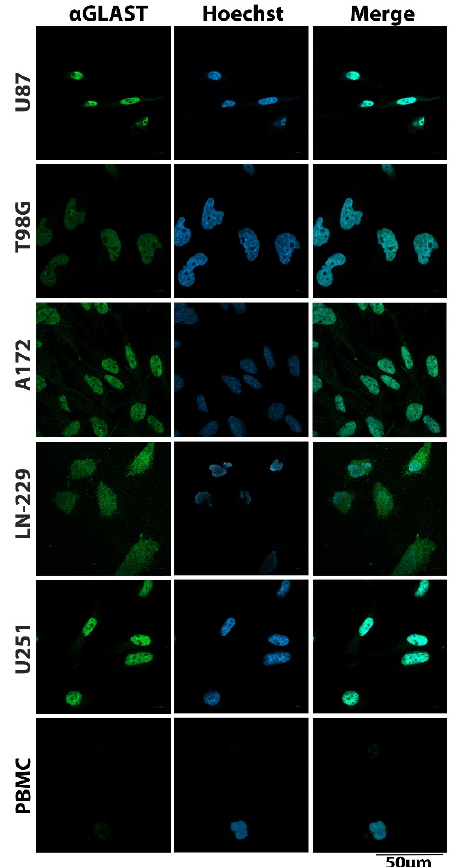
Figure 2. Glutamate aspartate transporter (GLAST) expression in GBM cells.